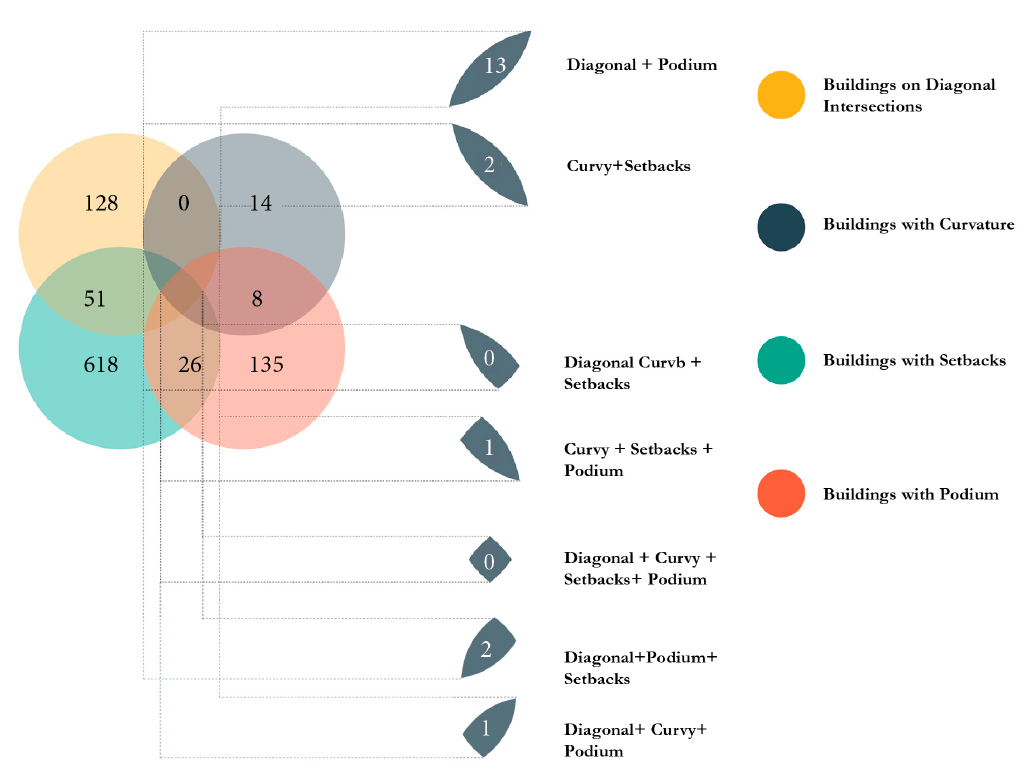
Figure 3. Incidence of external architectural design features. Figure 3 documents the incidence and overlaps of external architectural design features in our data set suggesting that some architectural features are related to one another.